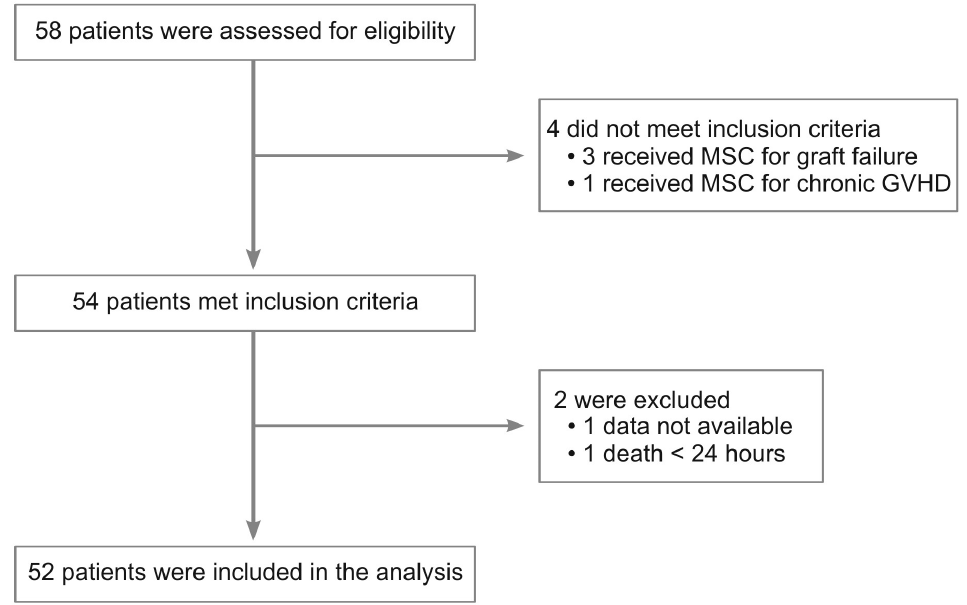
Figure 1. Flowchart showing the reasons for the exclusion of 6 patients, which resulted in a total of 52 patients included in the analyses.